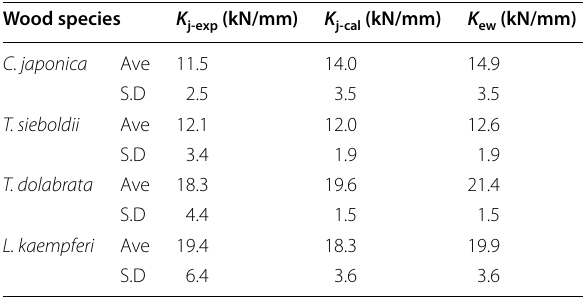
and K j-exp j-cal